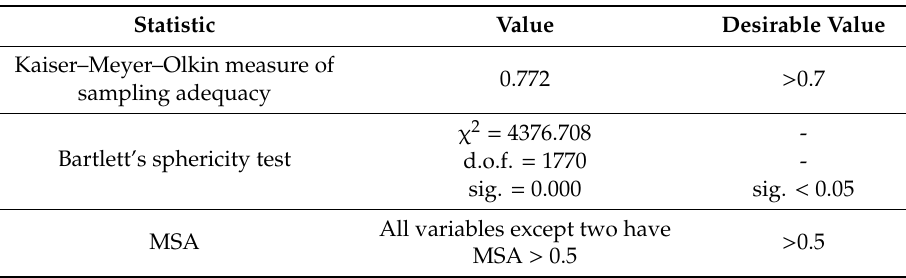
Table 3. Factor analysis suitability